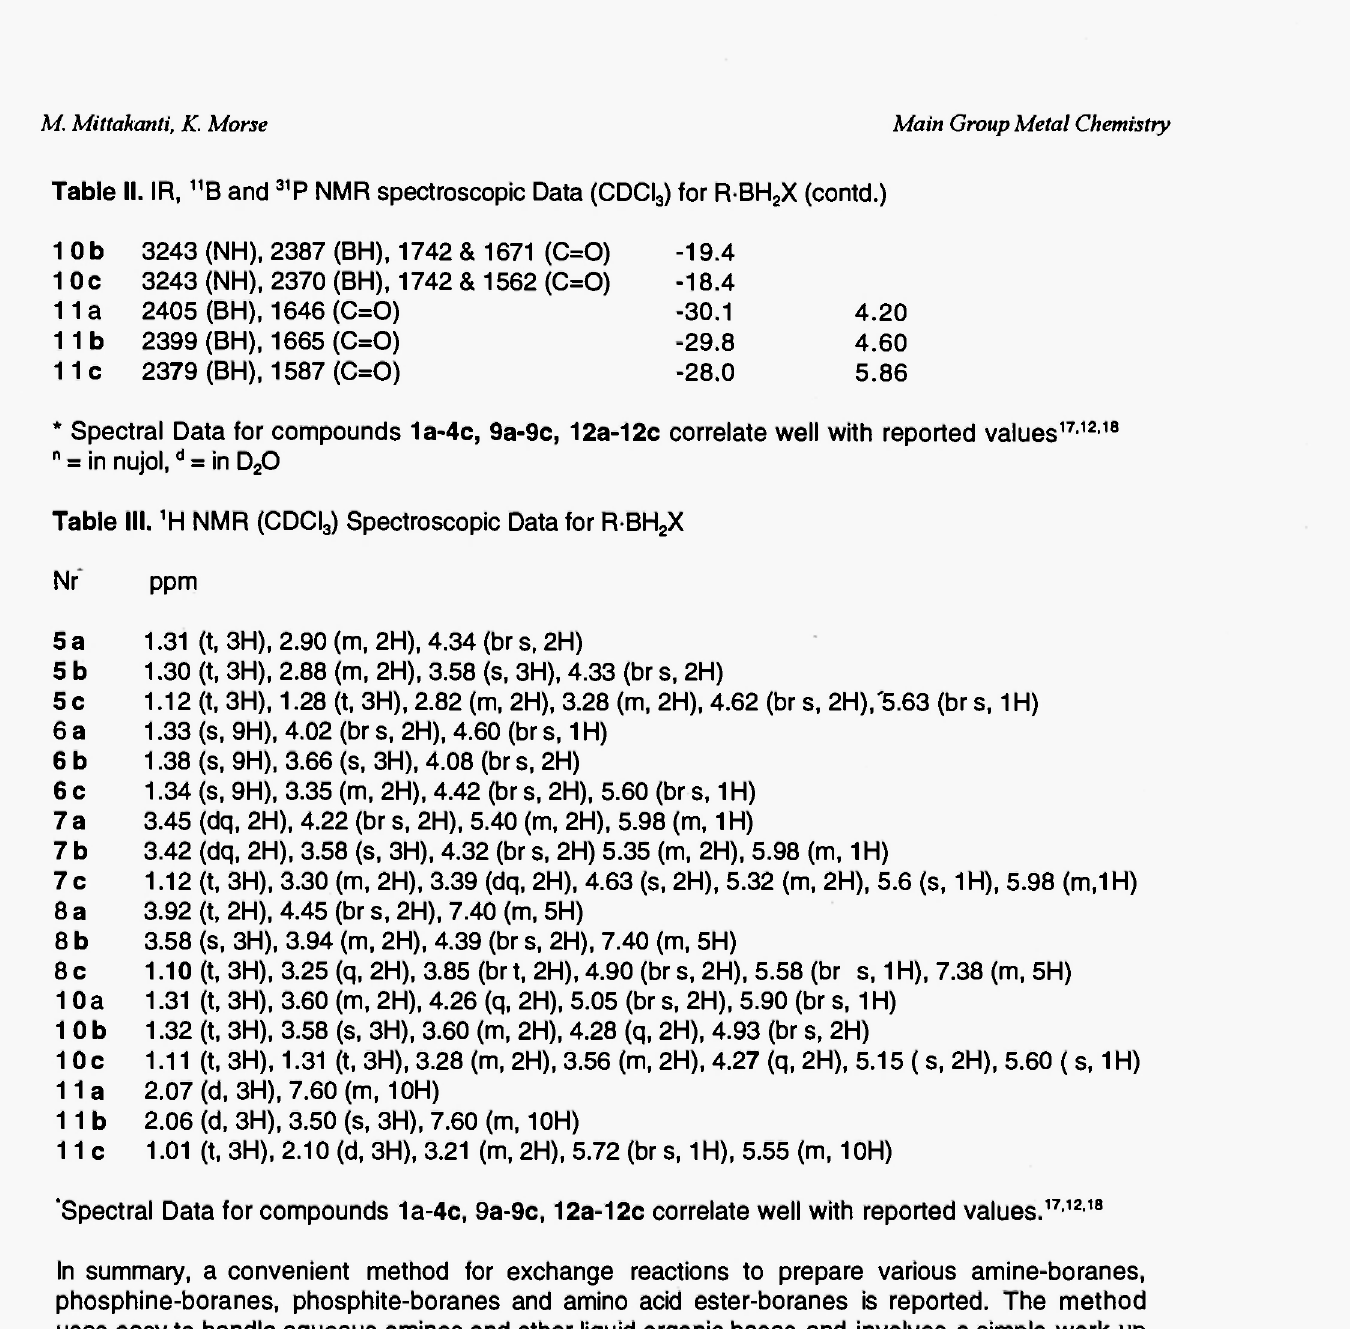
Table II. IR, 11 B and 31 P NMR spectroscopic Data (CDCI